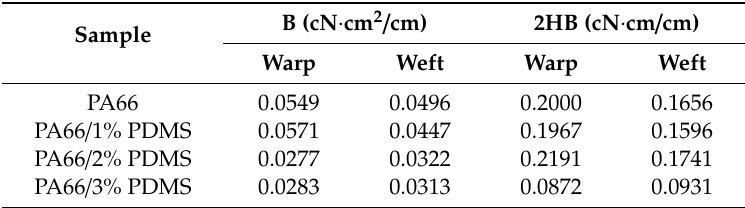
Table 3. Bending deformation properties of fabrics.